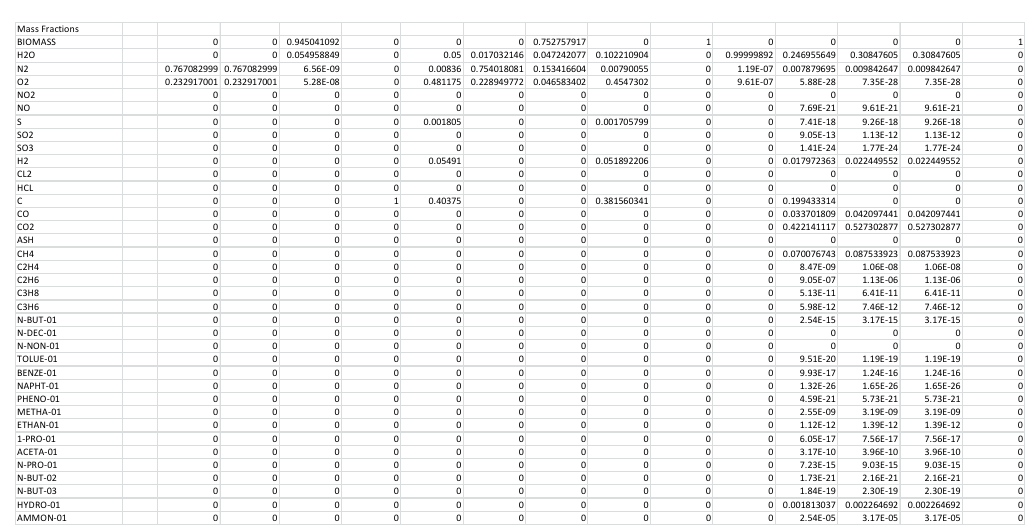
Figure A2. Pyrolysis stream results (mass fractions).